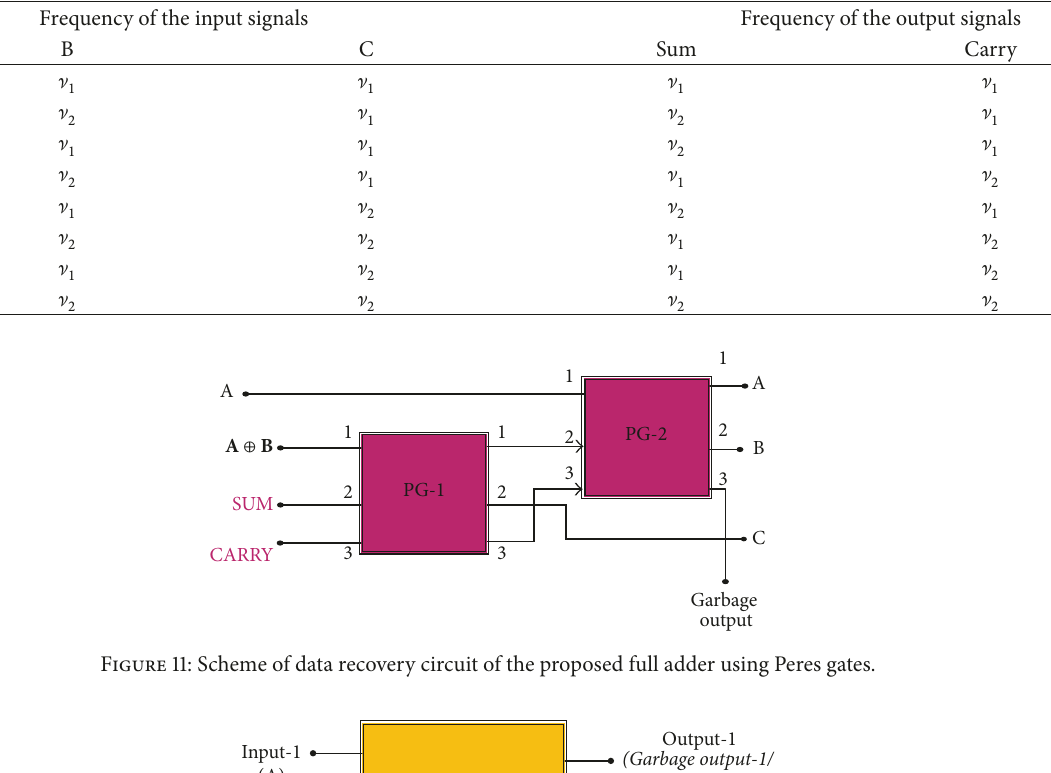
Table 3: Truth table of frequency encoded full adder.